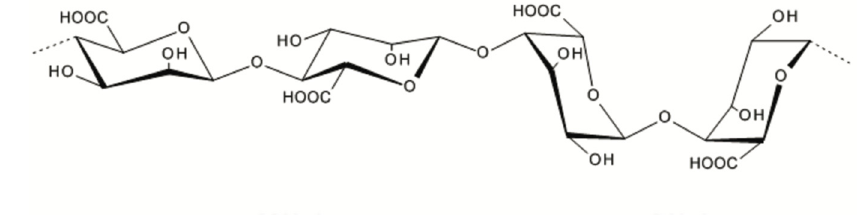
Figure 1. The chemical structure of alginate.